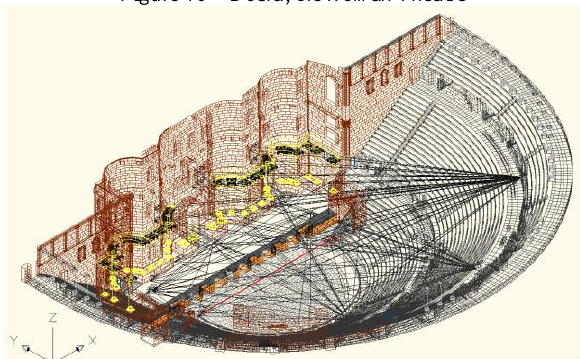
Figure 11 – The Roman theatre of Bosra (plot by